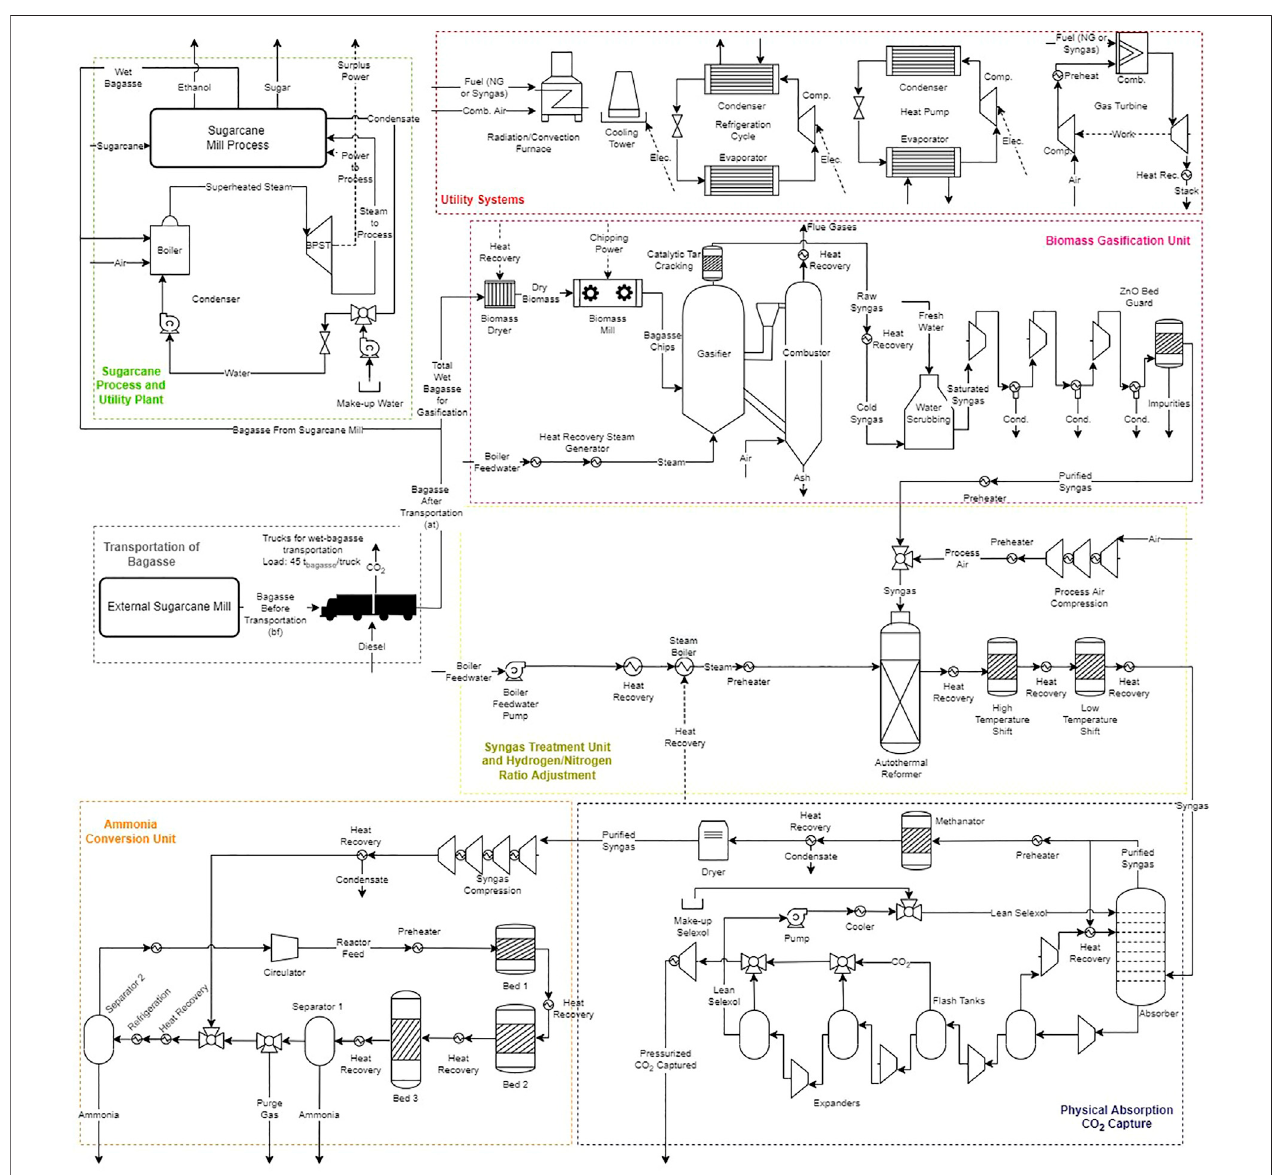
FIGURE2| Flowsheetofthealternativescenariosconsideringanintegratedsugarcanemillandanammoniaproductionplant.BPST,Backpressuresteamturbine; CST, Condensing steam turbine.